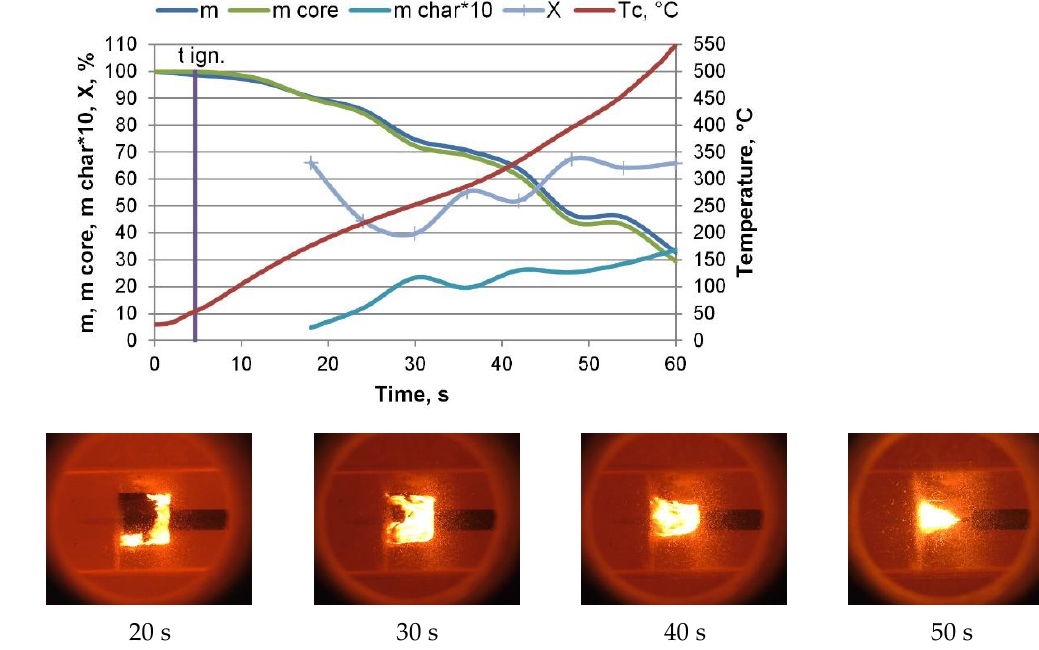
Figure 12. Characteristics of single-stage combustion of wood particles, T furnace—800 °C, air velocity—125 m s −1 : m —mass of the charred particle, m core —mass of particle wood core, m char —mass of the char layer, X —degree of overlapping of stages; t ign. —average time of particle ignition start, s; T c —temperature of the sample center, °C.